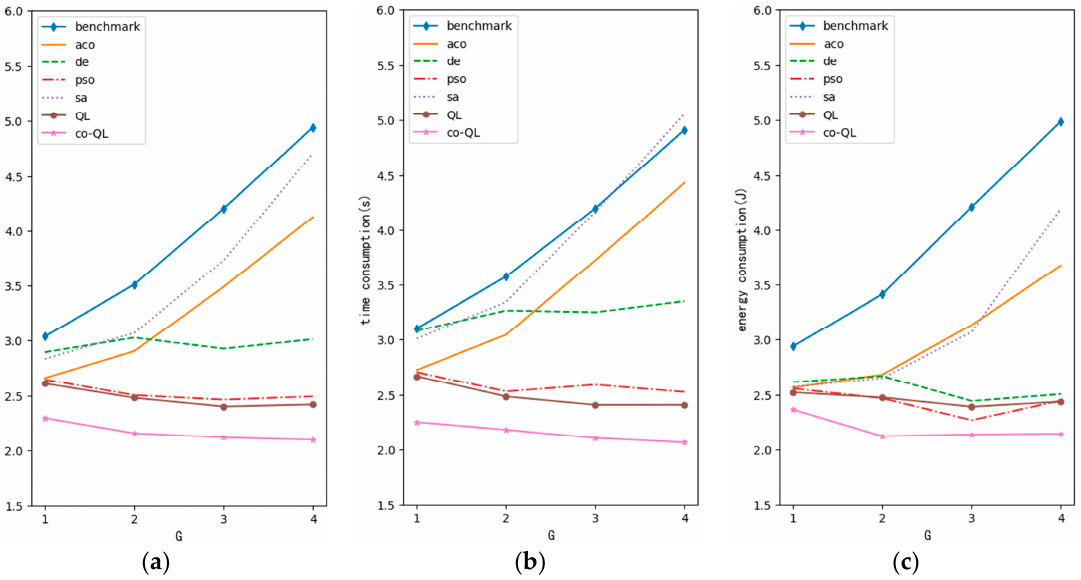
Figure 9. Optimization performance curve of variable G (M = 3, N = 3): ( a ) curve for value of objective function; ( b ) curve for time consumption; ( c ) curve for energy consumption.